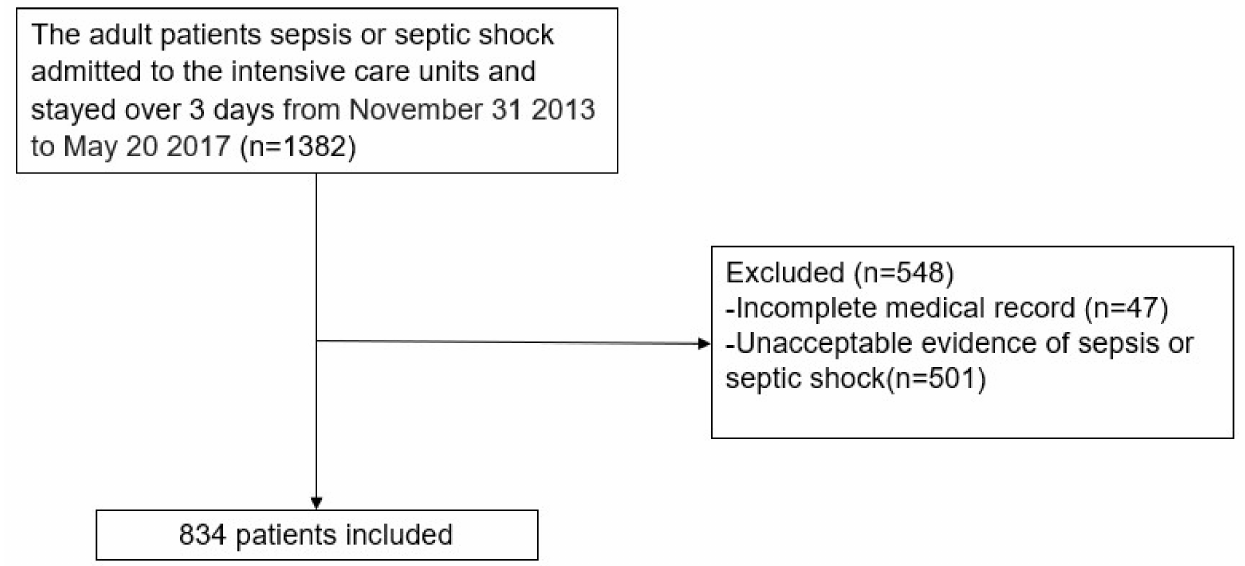
Figure 1. Patient selection flow